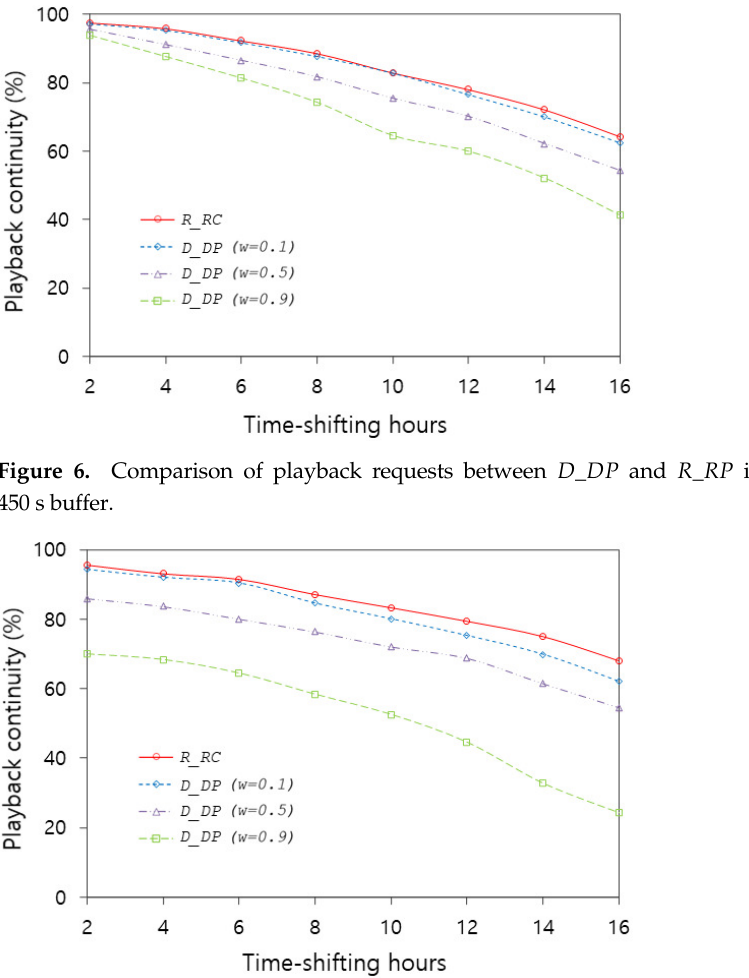
Figure 7. Comparison of playback requests between D _ DP and R _ RP in distribution 1 with a 300 s buffer.